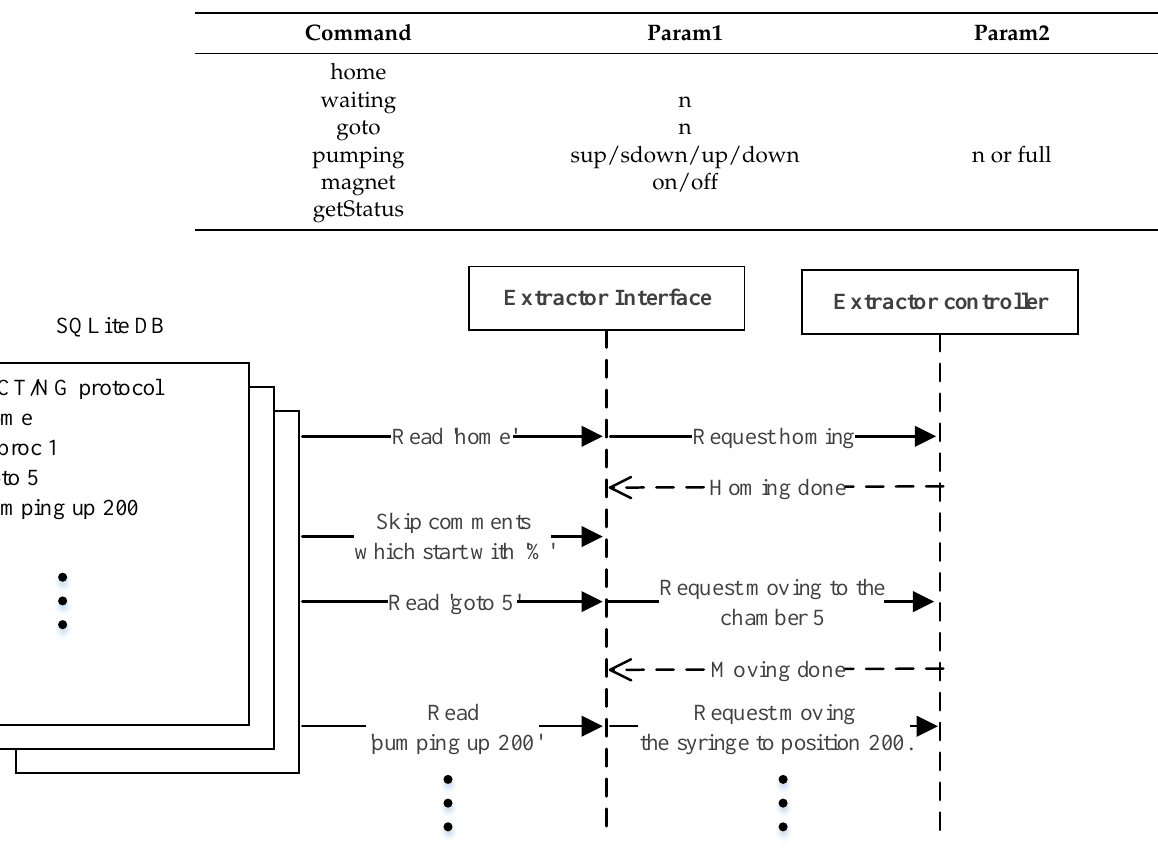
Figure 5. DNA extraction command flow example.